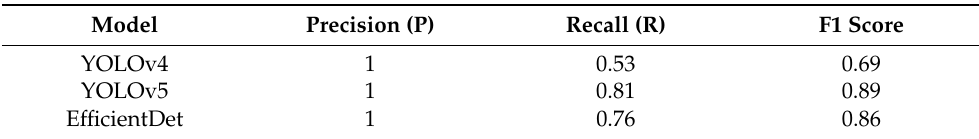
Table 7. Testing dataset accuracy evaluation with no threshold for YOLOv4 and threshold 0.5 for YOLOv5 and EfficientDet.